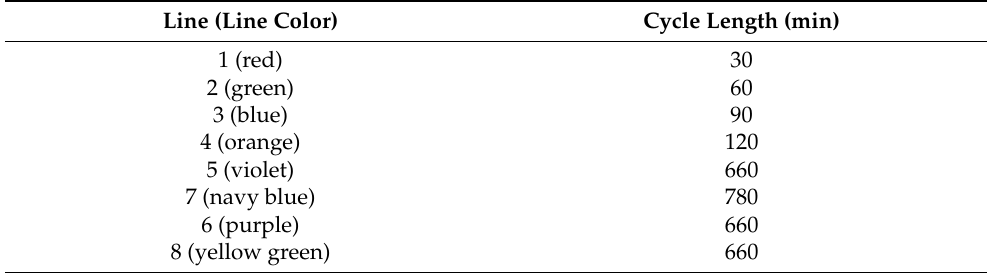
Table 20. Metrics of supply and demand matching of intercity